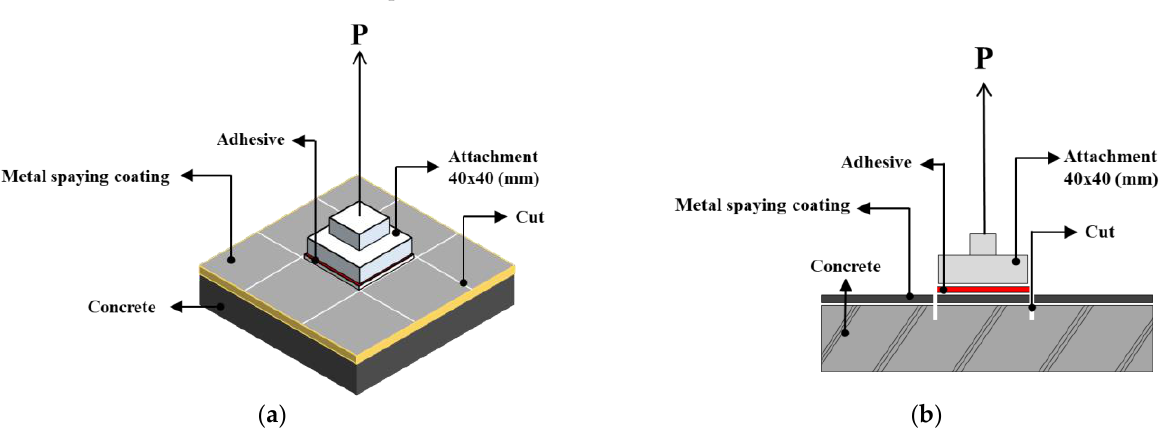
Figure 3. Temperature measurement overview. Table 8. Properties of the infrared thermometer used in this study.